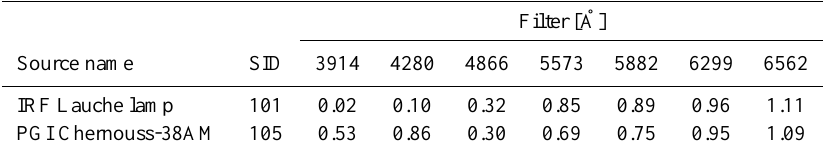
Table 4. Preliminary ratios of this intercalibration to measurements in November 2011 at the calibration laboratory at UNIS, Longyearbyen, Svalbard (2011c). The large differences for wavelengths below 5573 ˚A are expected since the IRF Lauche lamp is a tungsten lamp. For the PGI Chernouss-38AM source, the large difference at 4866 ˚A is more puzzling and remains to be explained. Filter [